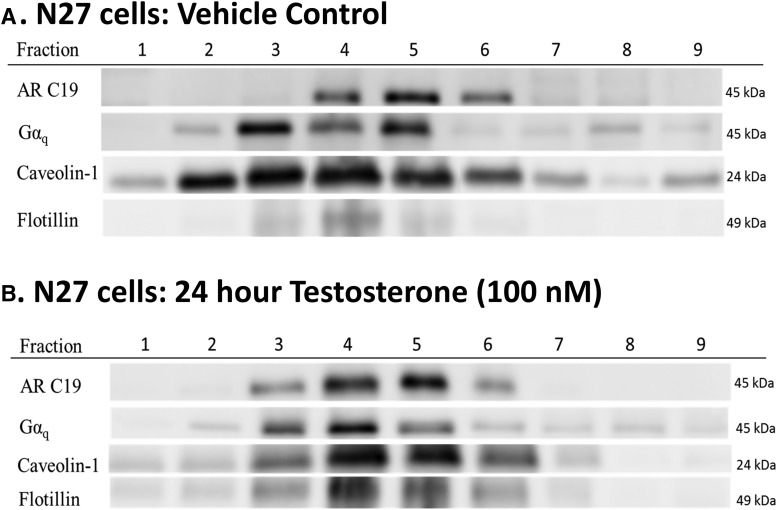
N27 cells express AR45 protein in membrane lipid rafts. N27 cells were treated with either vehicle control (A) or 100 nM testosterone for 24 h (B). The membrane portion of the cells were further separated into nine fractions using a sucrose gradient and ultracentrifugation to examine lipid rafts. Primary antibodies targeting AR45 (AR-C19 antibody), G protein Gαq, and lipid raft markers (caveolin-1 and flotillin) were used. AR45 and Gαq expression were observed only in lipid raft fractions, as evidenced by caveolin-1 and flotillin expression. Hormone treatment did not alter AR45 and Gαq expression in lipid rafts. Full-length (110-kDa) AR, Gαo, Gαi1-3, and Gαs G proteins were not observed in the membranes of N27 cells (data not shown). n = 3 per treatment group.